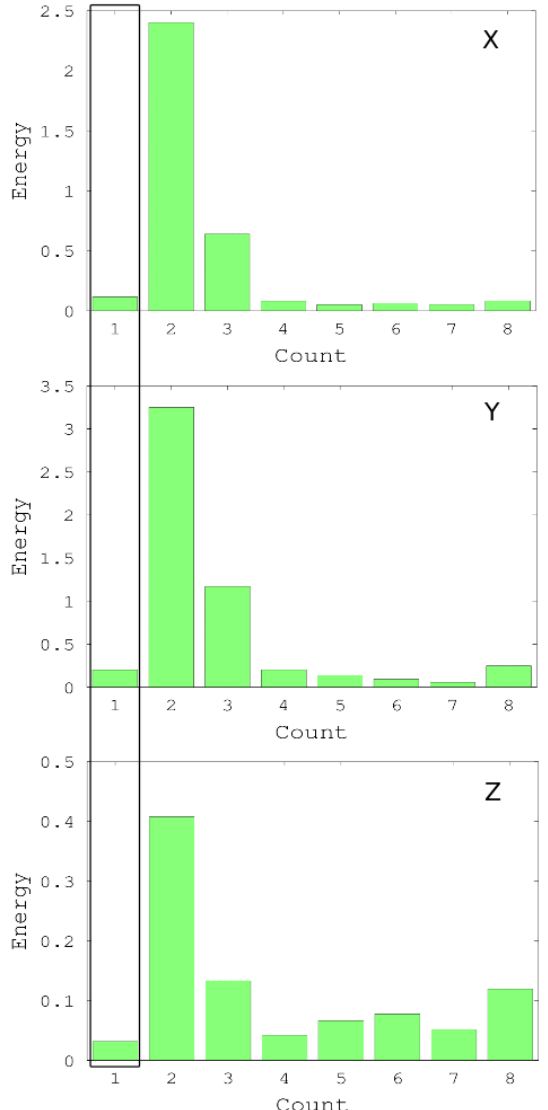
Fig. 4. An example how to perform the minimum energy application for the spectral density analysis based on WT. The first, second, and third panels indicate energy of the X,Y , and Z components on 18 September 2009, respectively. The black square corresponds to the period of the minimum energy of Z component. The spectral density ratio with the minimum application is computed from the energy values of X,Y, and Z components in the square.